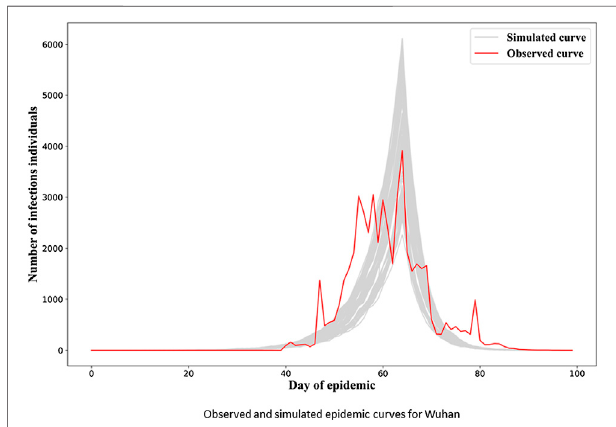
FIGURE 3 | Observed and simulated epidemic curves under fi nal model for Wuhan. Real data shown in red; dark gray curves represent 70% of curves simulated from the fi nal model closest to the true curve.